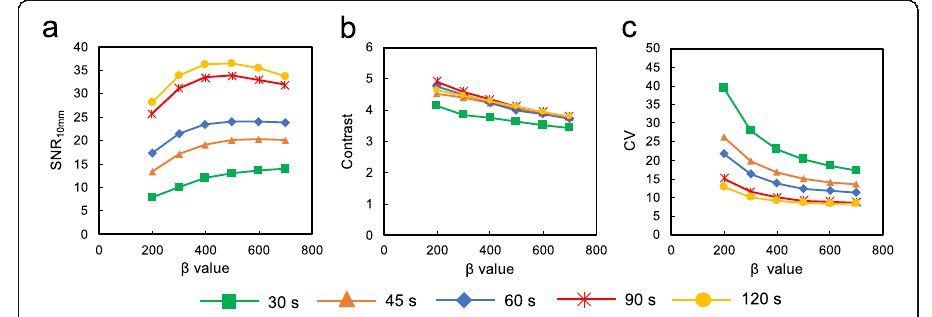
Fig. 3 PET image quality of 10-mm spheres as a function of β value (range 200 – 700) for each acquisition